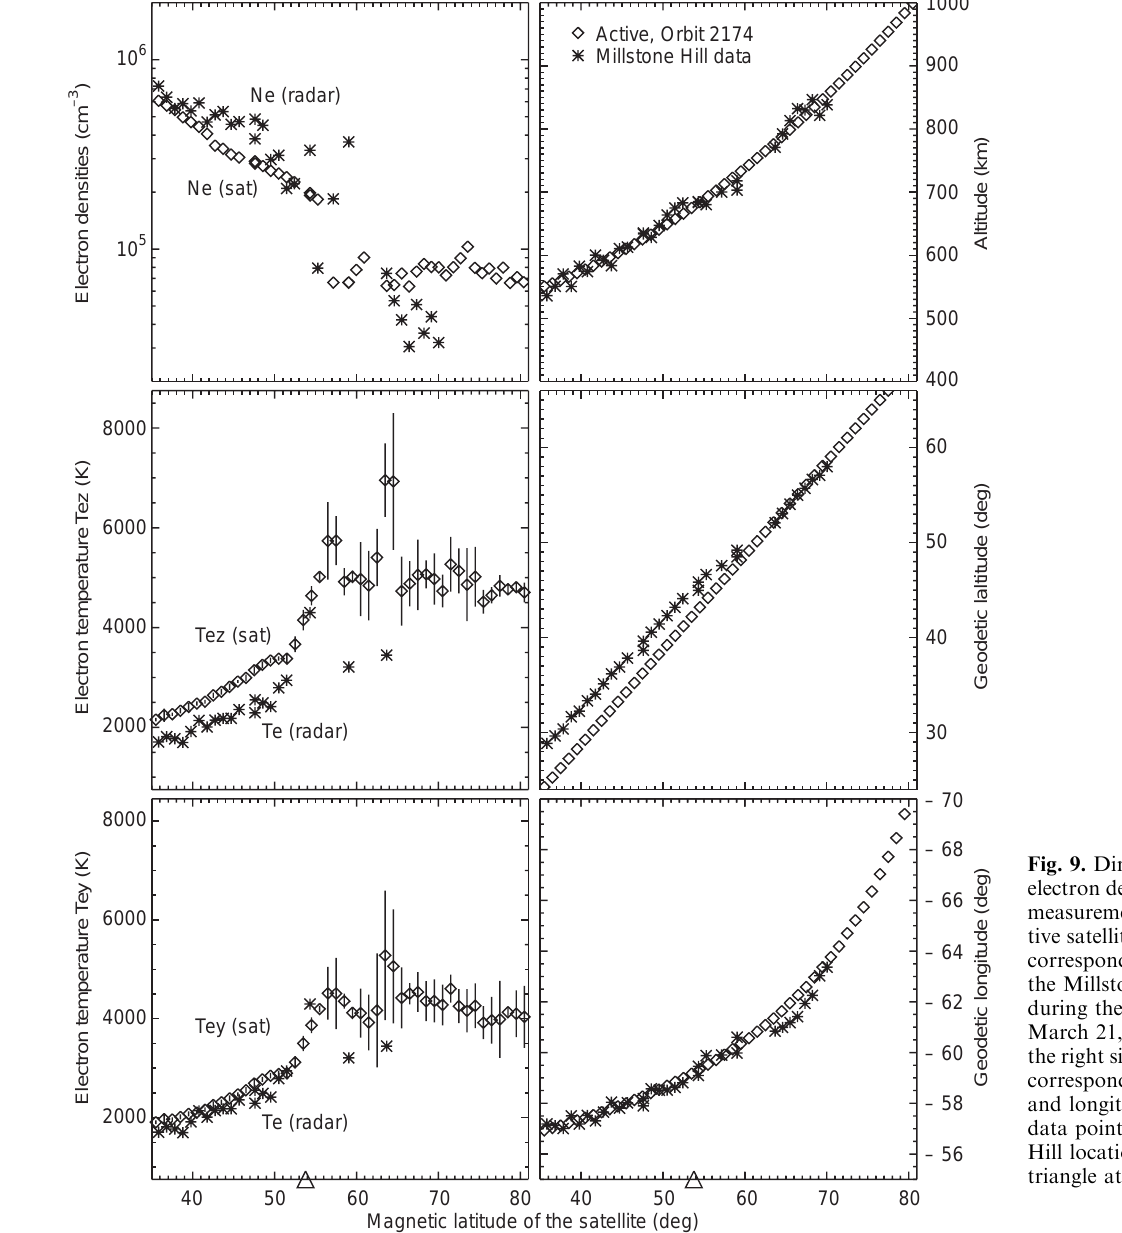
Fig. 9. Direct comparison of the electron density and temperature measurements onboard the Ac- tive satellite (diamonds) with the corresponding observations of the Millstone Hill radar (stars) during the overflight 2174 on March 21, 1990. The panels on the right side show as a check the corresponding altitude, latitude and longitude positions of the data points used. The Millstone Hill location is indicated by a triangle at